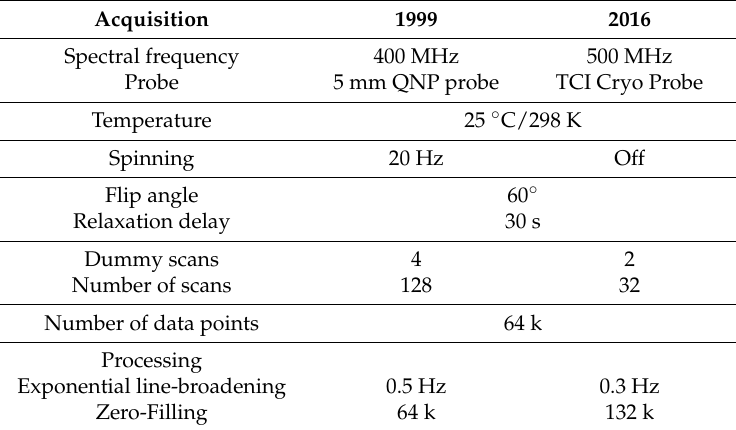
Table 4. Acquisition and processing settings of the qNMR experiment.